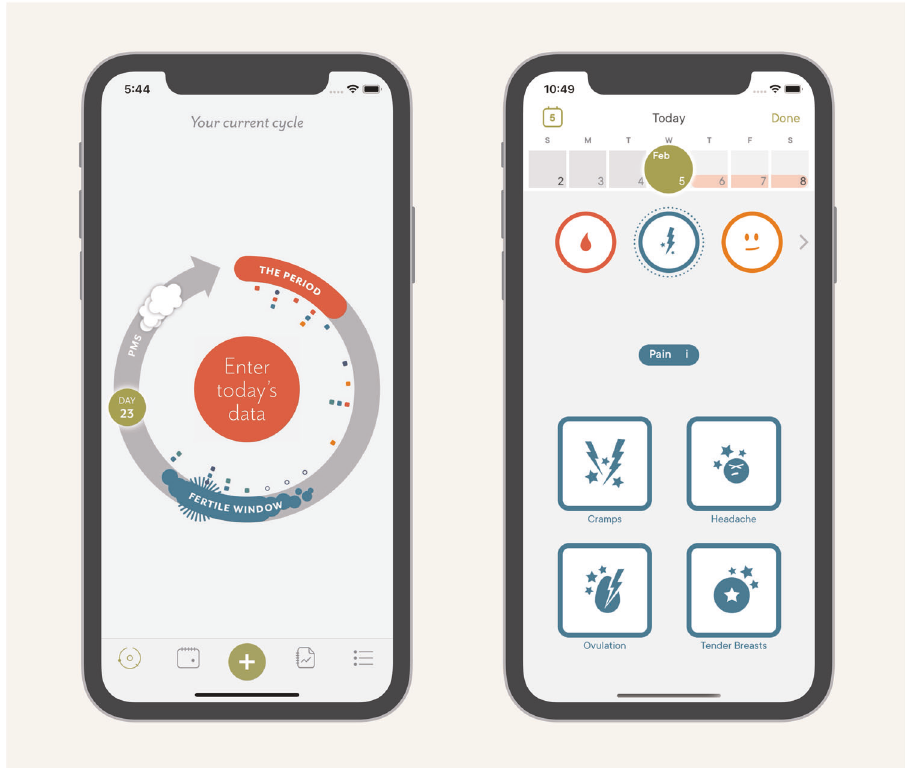
Fig. 1 Clue app screenshot. Sample screenshots of the Clue app. Users can track daily symptoms across 20 categories; Table 3 provides a description of the available Clue categories and their corresponding symptoms. On the left for example, the app displays what day the user is currently on in their cycle. On the right, a user can choose from ‘ cramps, ’ ‘ headache, ’ ‘ ovulation, ’ or ‘ tender breasts ’ symptoms for the category ‘ pain ’ (the third most tracked category in our dataset, see Table 3). Screenshots produced by and used with permission from Clue by BioWink